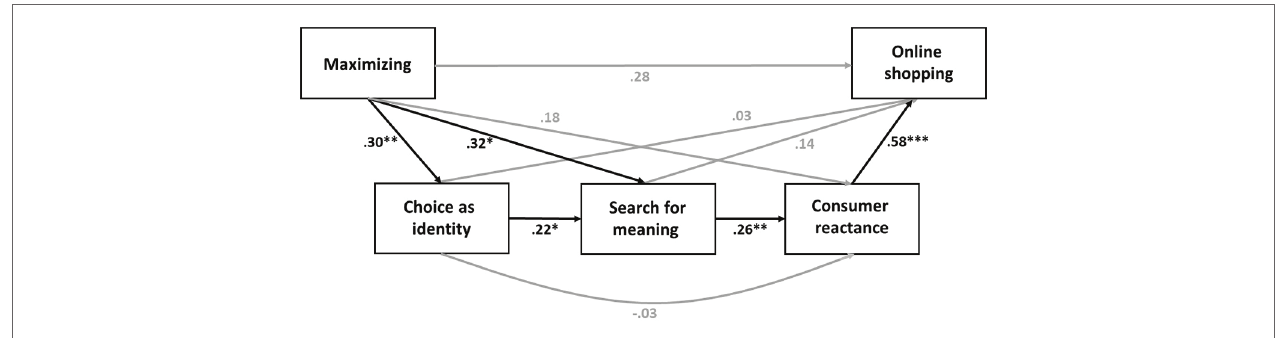
FIGURE 1 | Conceptual model results. *** p < 0.001; ** p < 0.01; and * p < 0.05. Unstandardized coefficients are provided along the paths. The indirect effect of maximizing on online shopping via choice as identity, search for meaning, and consumer reactance: B = 0.0100, SE (Boot) = 0.0083, 95% CI = (0.0004, 0.0321). All other models with alternative orders of the variables were not significant: search for meaning – reactance – choice as identity: B = 0.0000, SE (Boot) = 0.0017, 95% CI = ( − 0.0032, 0.0038); reactance – choice as identity – search for meaning: B = 0.0001, SE (Boot) = 0.0011, 95% CI = ( − 0.0018, 0.0029); reactance – search for meaning – choice as identity: B = 0.0002, SE (Boot) = 0.0027, 95% CI = ( − 0.0040, 0.0069); search for meaning – choice as identity – reactance: B = − 0.0009, SE (Boot) = 0.0049, 95% CI = ( − 0.0122, 0.0084); and choice as identity – reactance – search for meaning: B = 0.0002, SE (Boot) = 0.0023, 95% CI = ( − 0.0034, 0.0059).